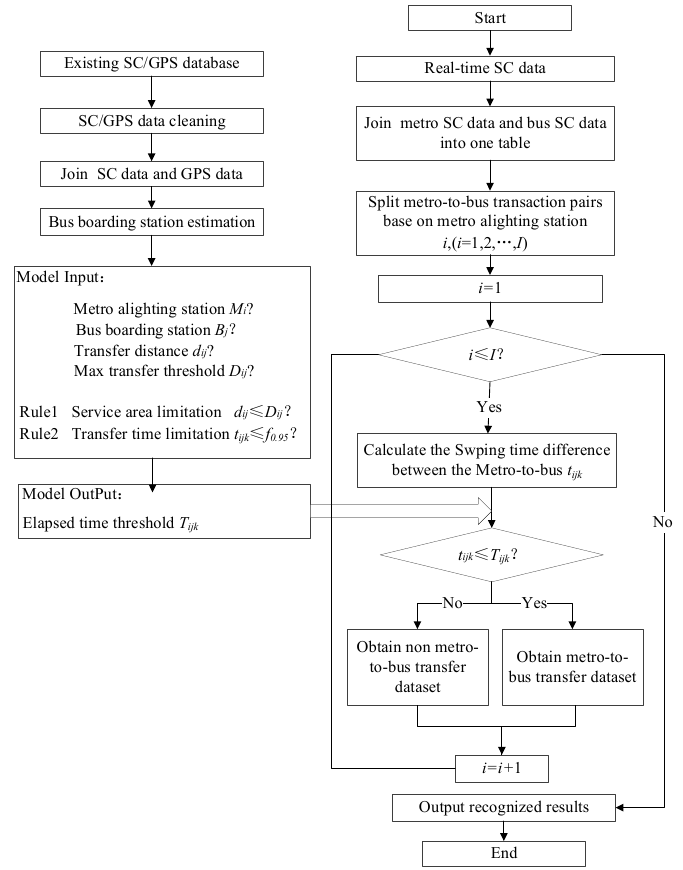
Figure 5. The algorithmic framework for metro-to-bus interchange behavior identification.